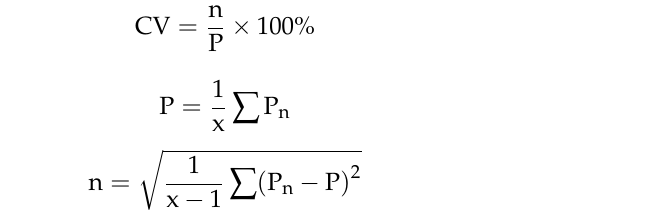
Table 4. Orthogonal test factor levels.